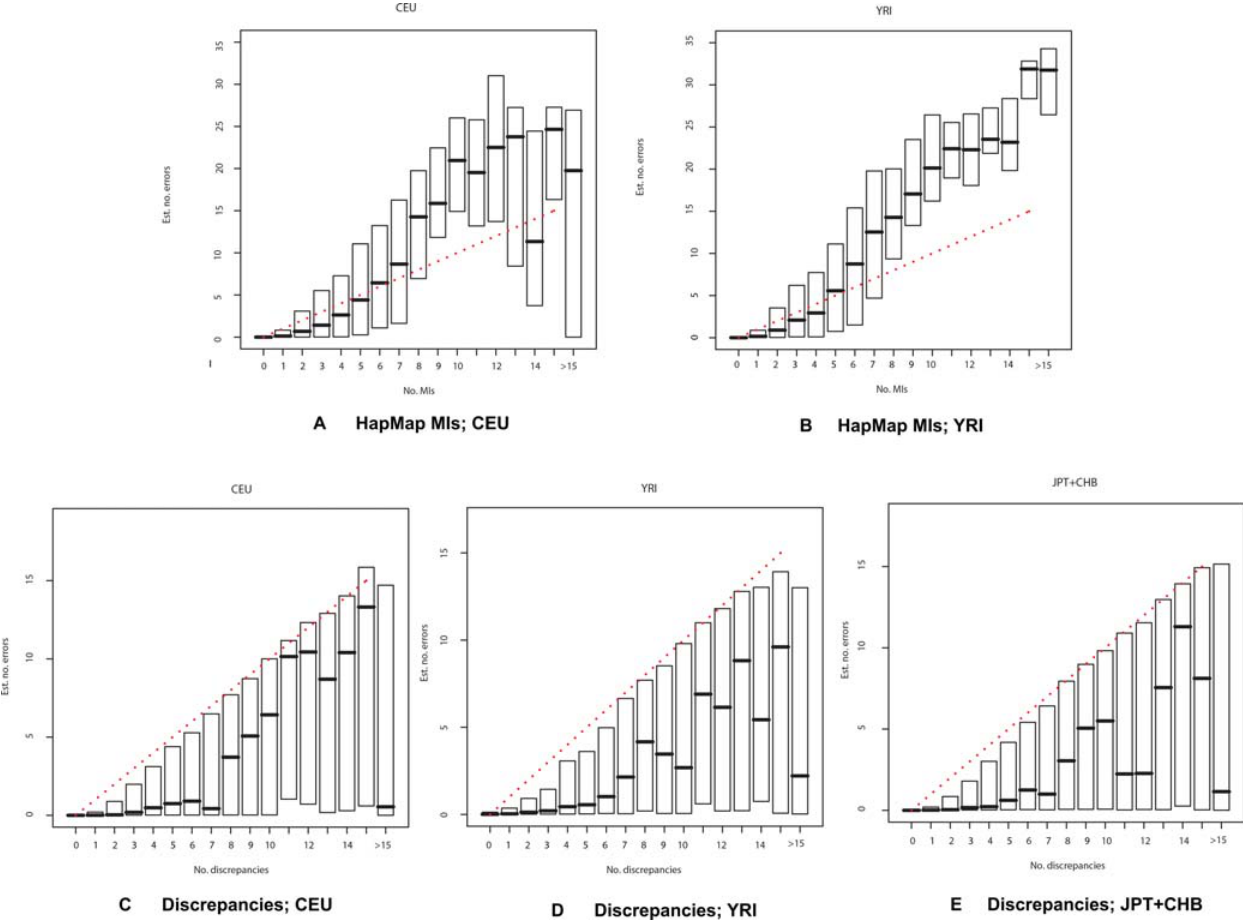
Figure 1. SNP-specific estimates of number of errors based on LD correlate with number of MIs and discrepancies. Each plot contains a box corresponding to the number of observed MIs or discrepancies (horizontal axis). The position of the bottom and top of a box relates the first and third quartiles of the estimated number of MIs or discrepancies (vertical axis), with the median displayed as a horizontal line in the middle of each box. The red dotted line indicates equality between the number of estimated errors and observed MIs or discrepancies. First row (A-B) : The total number of expected errors at each SNP, based on LD, was calculated for the HapMap data and plotted against the number of MIs. Second row (C-E) : The total number of expected errors at each SNP, based on LD, was calculated for the Affymetrix data, and plotted against the number of discrepancies between the Affymetrix and HapMap genotype calls. In general, the median and the upper quartile for the number of estimated errors increase with the number of discrepancies/MIs. The fact that the lower quartile is at 0 in (C-E), even for SNPs with many discrepancies, could partially reflect the existence of SNPs with many discrepancies, but with few errors in the Affymetrix data (the discrepancies being due to errors in the HapMap